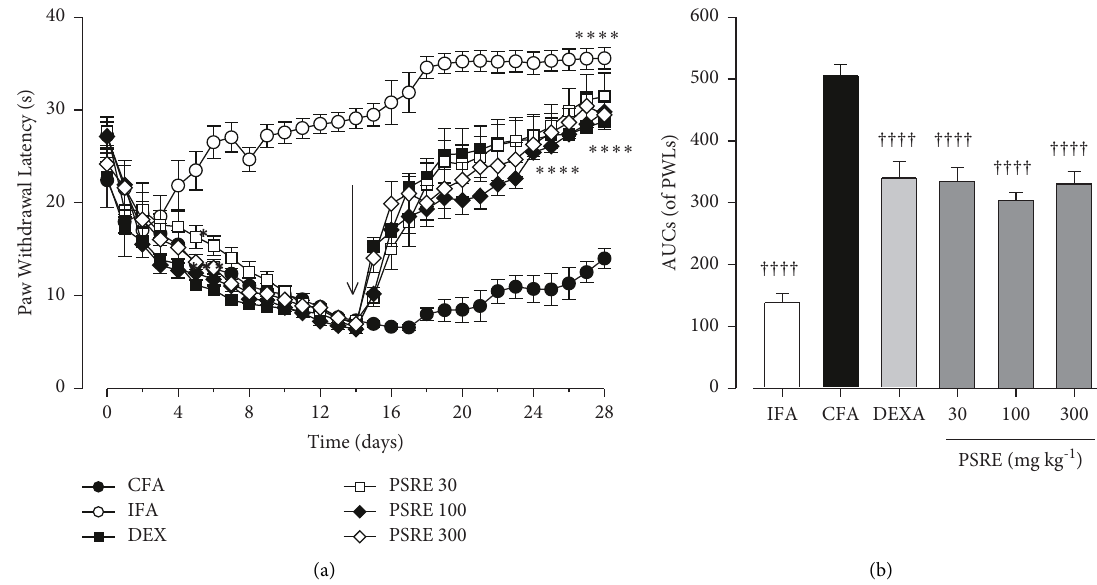
Figure 6: Effect of PSRE (30–300 mg kg − 1 ) and dexamethasone (0.3mg kg − 1 ) on time-course curves of paw withdrawal latencies (a) and AUCs (b) in the therapeutic protocol of adjuvant-induced arthritis in rats. Values represent mean compared to the CFA group (Two-way ANOVA followed by Tukey’s multiple comparison test). †††† P (One-way ANOVA analysis followed by Tukey’s multiple comparison